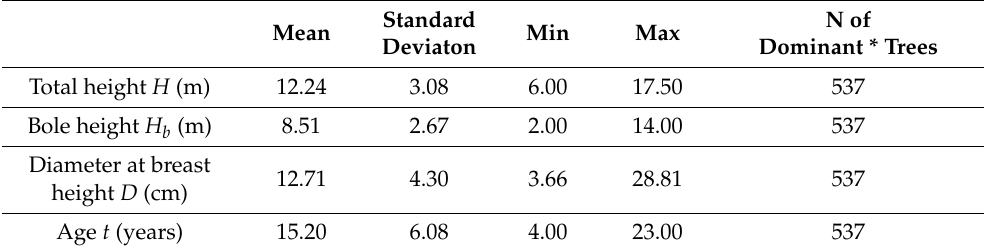
Table 1. Summary statistics for input data (measurements on dominant trees).